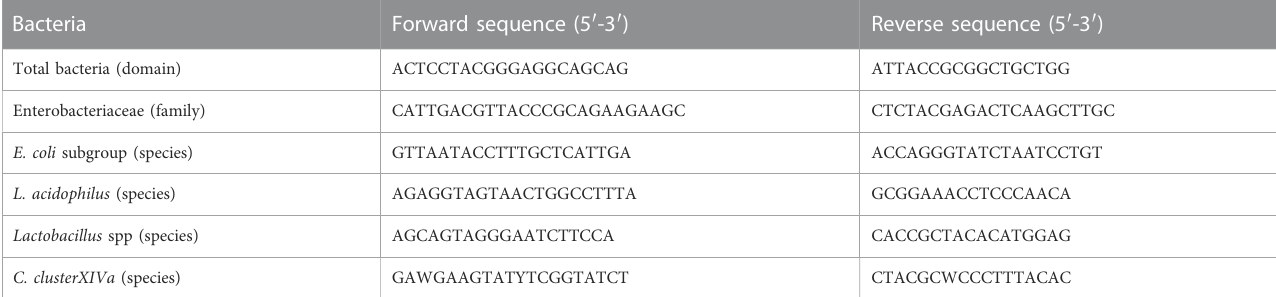
TABLE 5 Sequence of primers used in this